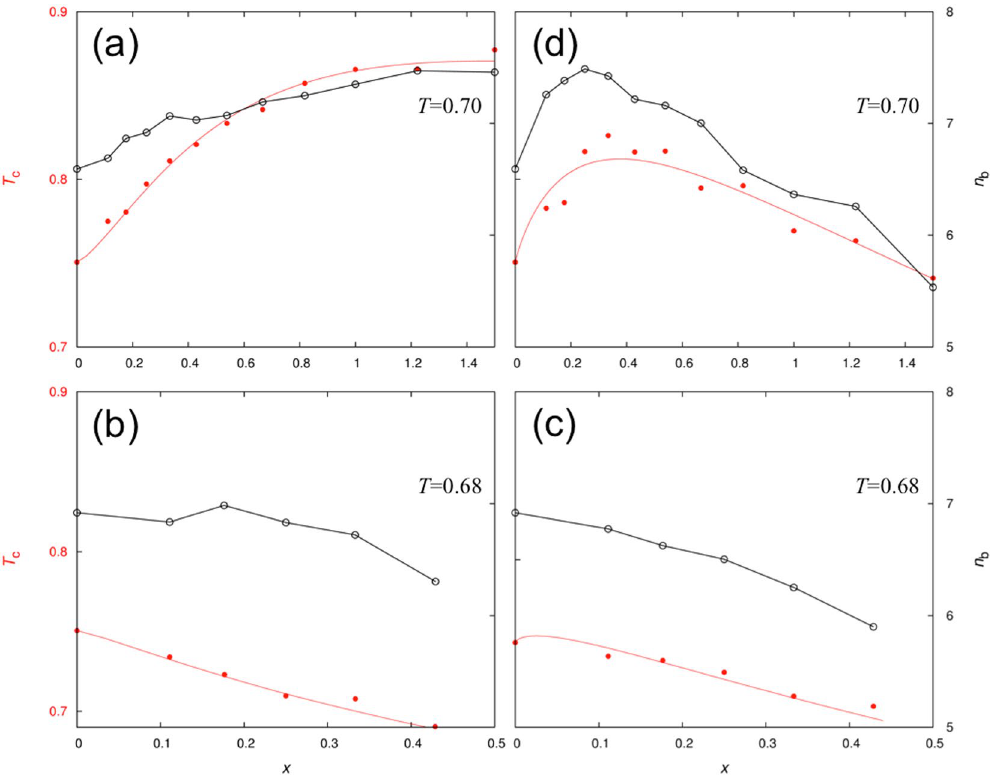
Figure 4. Correlation between critical temperature and average number of bonds per particle in the droplet phase. Results at ε PR = 0.0, 0.5, 1.0, and 1.35 are shown in ( a – d ), respectively. A smooth curve through the T c data points is drawn to guide the eye; neighboring data points for n b are connected by line segments. The latter are for the temperatures